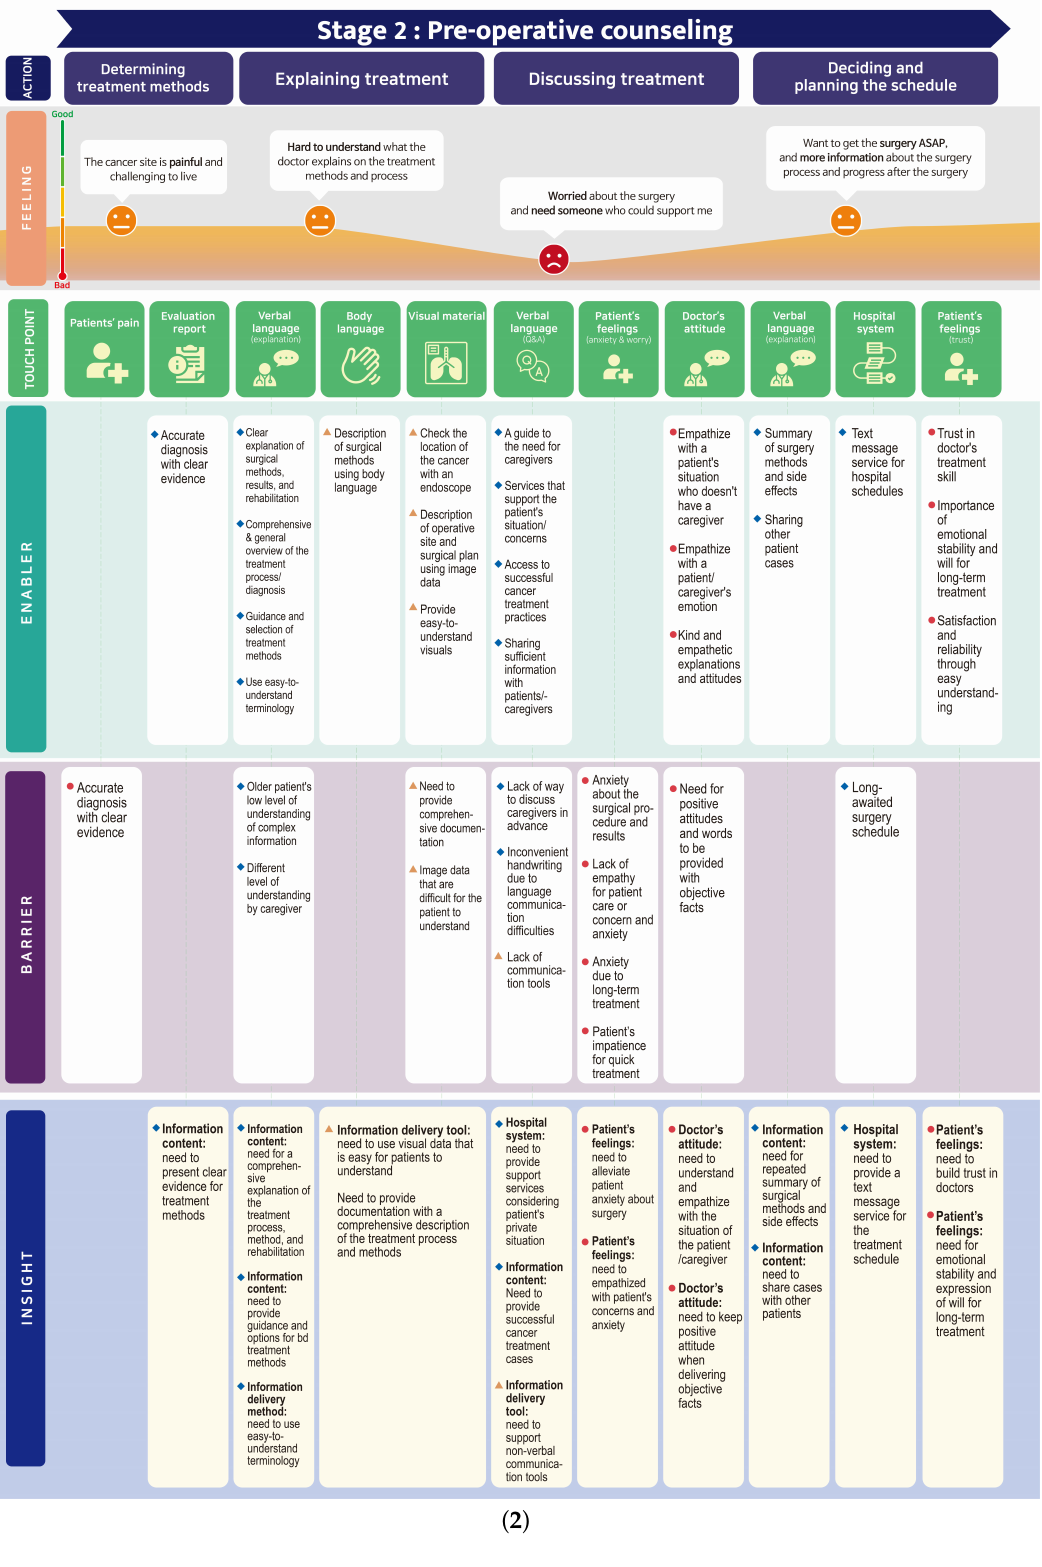
Figure 3. This is a wide figure. Figure 3. Cont